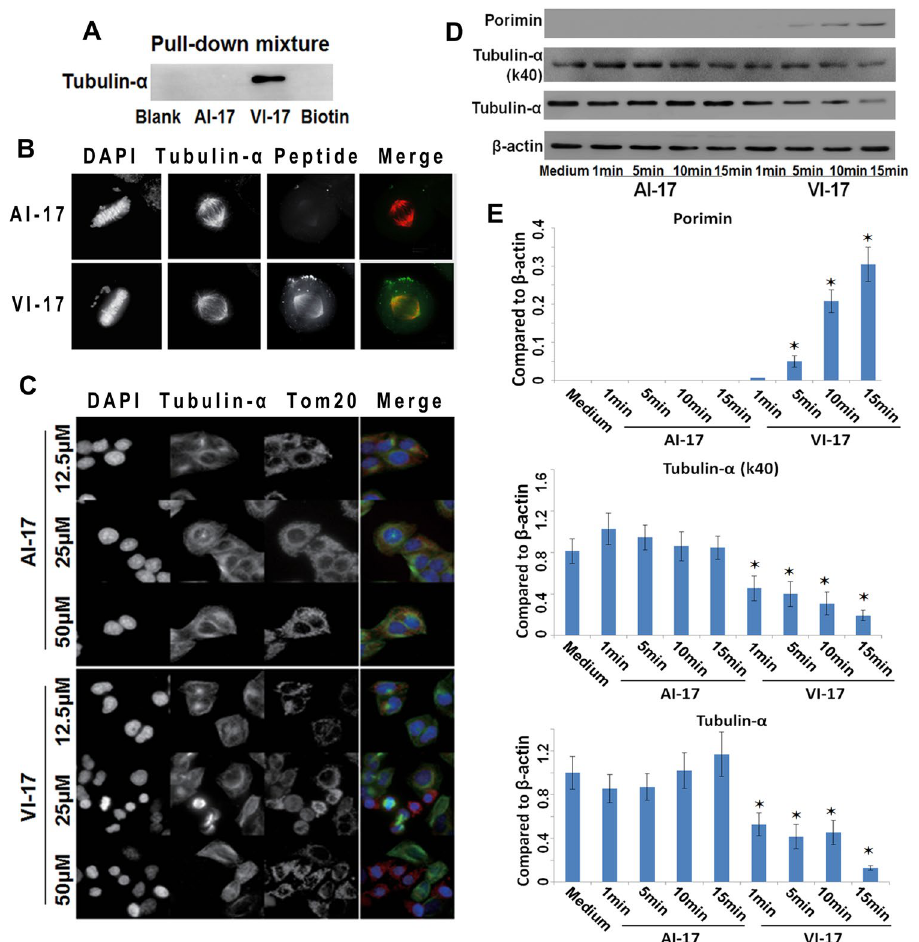
Figure 7. VI-17 interacted with tubulin-α, and induced tubulin-α degradation and porimin exposure. (A) Western blot analysis of candidate binding partners of VI-17 in pull-down mixture using biotin-VI-17 from Hep3B cells. (B) Immunofluorescence for cellular location of VI-17 and tubulin-α in VI-17 treated Hela cells. Original magnification: × 400. (C) Immunofluorescence for tubulin-α degradation and mitochondria swell in VI-17 treated Hep3B cells. Original magnification: × 200. (D) Western blot analysis of the expression of tubulin-α and porimin in VI-17 treated Hep3B cells at indicating time points. (E) Gray value analysis for the band in D . *p <